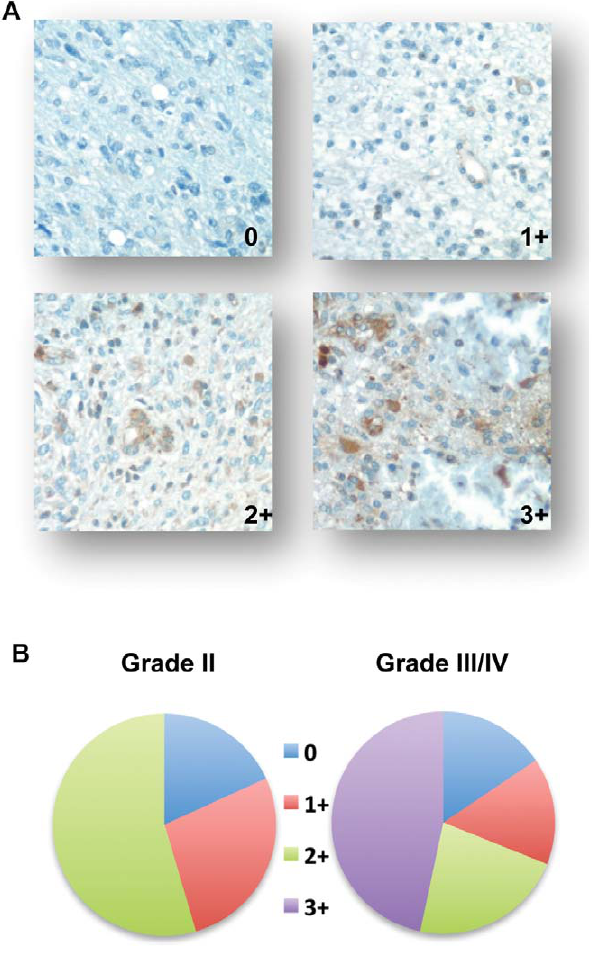
Figure 1. GRP78 expression in glioma. Immunohistochemical staining was performed on a glioma tissue microarray using an anti- GRP78 antibody and expression levels (0, 1 + , 2 + , and 3 + ) were quantified based on the intensity of staining. Representative staining patterns (A) and tumor grade-specific distributions of identified staining intensities (B) are